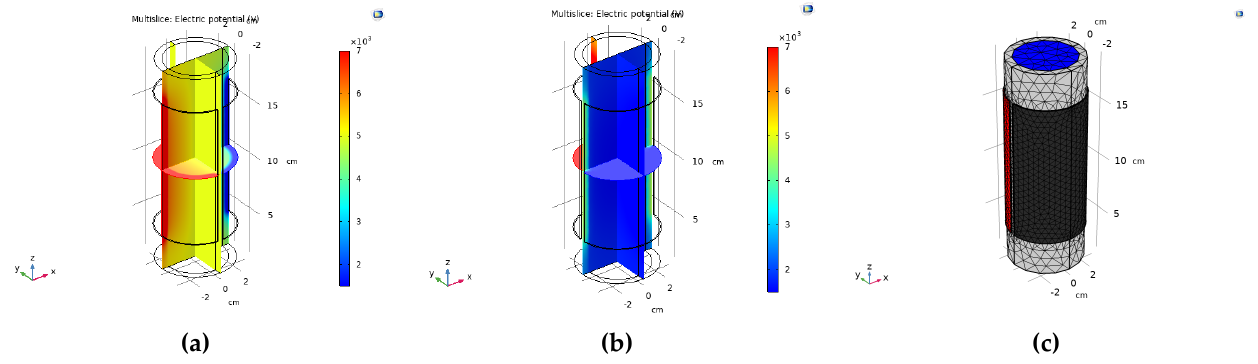
Figure 9. Electrical potential of the concave sensor in ( a ) Horizontal orientation, ( b ) Vertical orientation and ( c ) Meshed model of the horizontal concave sensor. Table 4. Measured capacitance values in different void fractions for concave sensor in simulations.